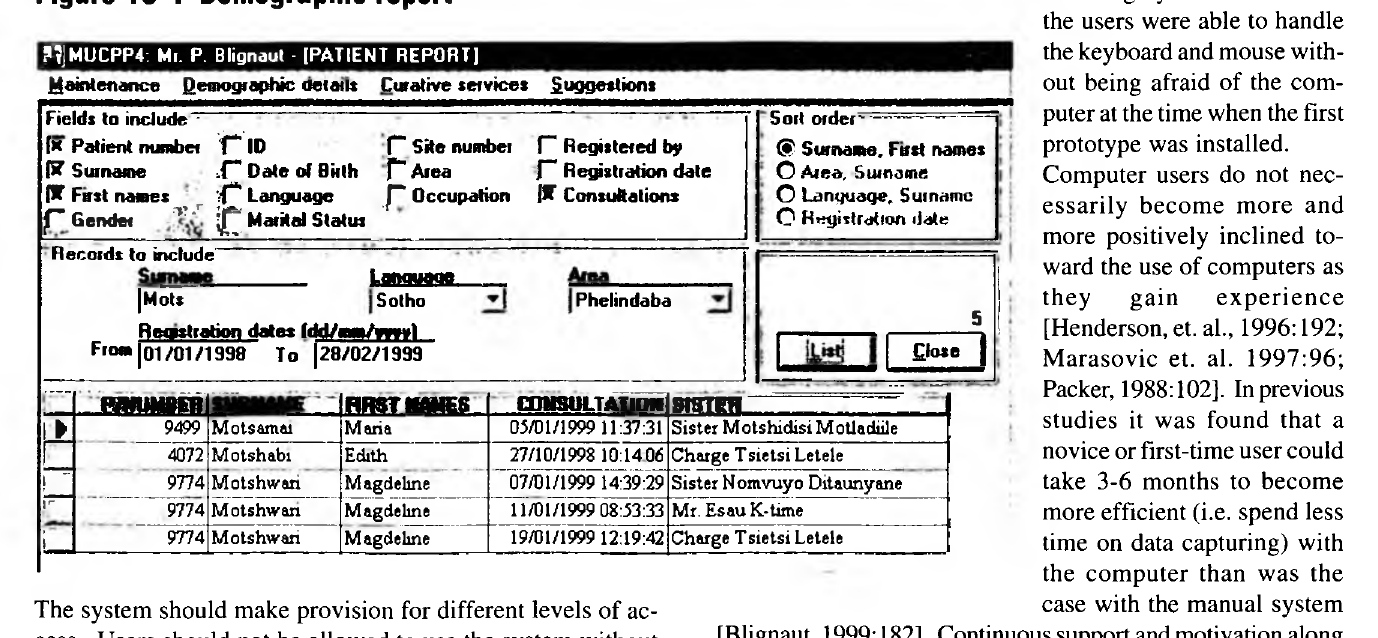
Figure 10 : Demographic